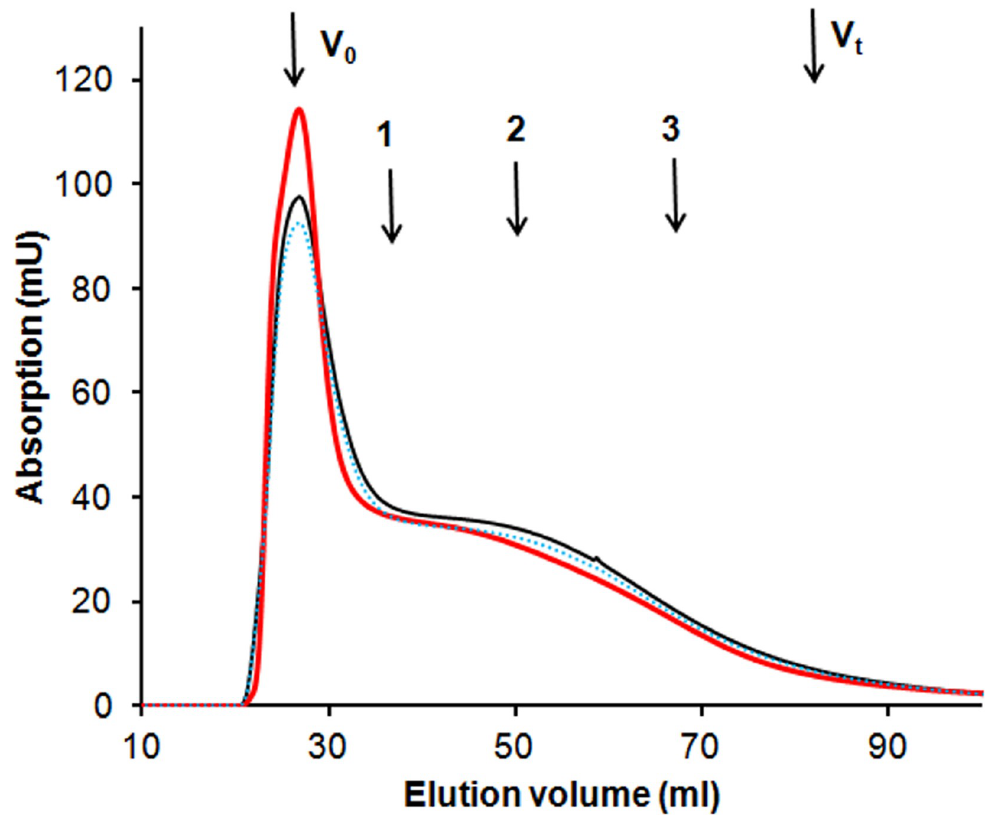
Fig 3. Gel-filtration profiles for the transformation of sod-podzolic humic acid (HA) by SpSL. Solid red line–HA after interaction with SpSL, thin black line–initial HA, dotted blue line–control with inactivated SpSL. Arrows indicate the void volume (V 0, > 80 kDa), the total void volume (V t , < 5 kDa), 1—bovine serum albumin (66 kDa), 2—carbonic anhydrase (29 kDa), cytochrome c 12.4